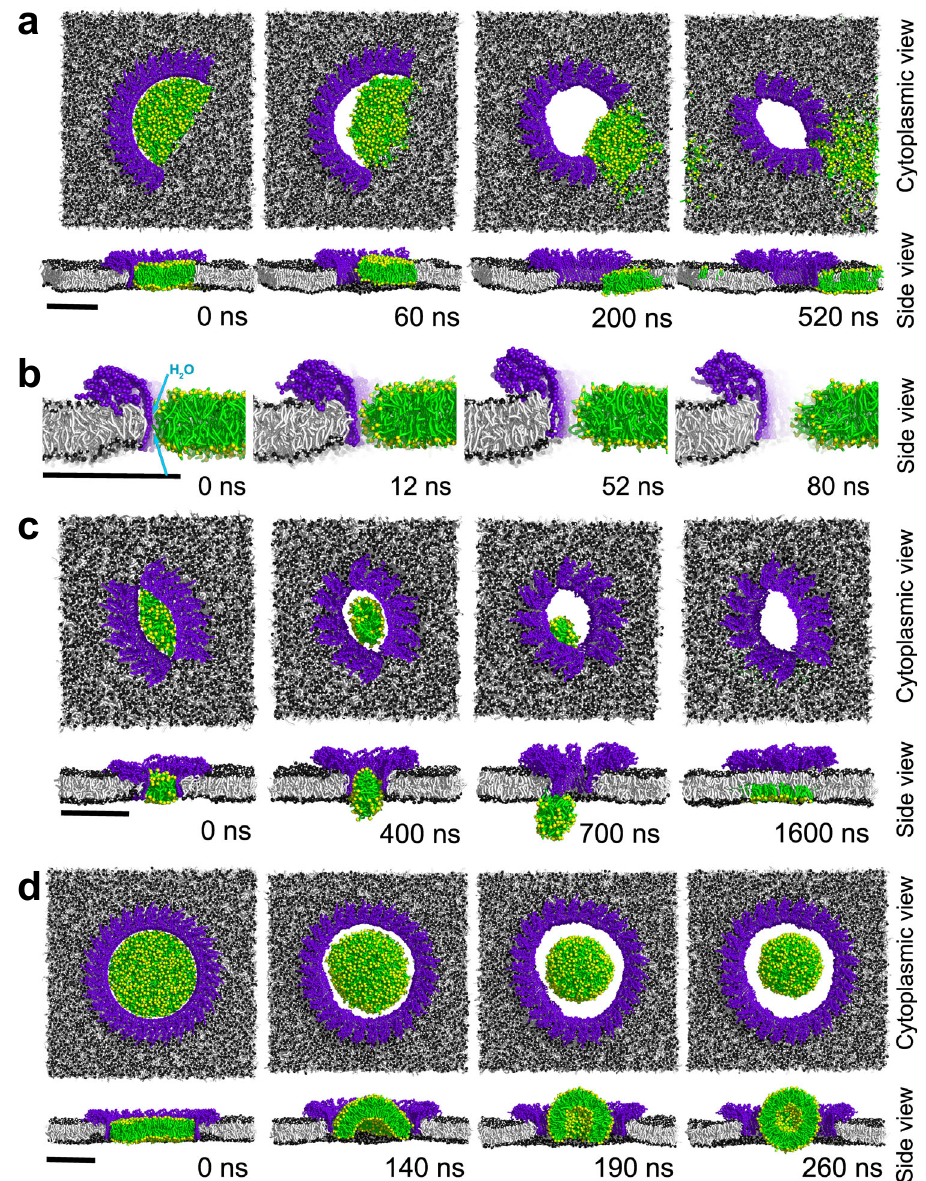
Fig. 7 Pore formation of membrane-inserted mGSDMA3 Nterm oligomers. a Pore formation of an arc-shaped oligomer assembled from 16 mGSDMA3 Nterm ( n = 8/8 simulations). b Lipid withdrawal from mGSDMA3 Nterm forming the arc-shaped oligomer shown in ( a ) at higher time resolution and structural detail. The hydrophilic (polar) surface of the transmembrane β -sheet formed by adjacent mGSDMA3 Nterm causes water to penetrate into the membrane. The intrusion of water along the β -sheet is followed by the reassembly of lipid headgroups (yellow), whose withdrawal from the hydrophilic surface opens the transmembrane pore. c Pore formation of a slit-shaped oligomer assembled from 14 mGSDMA3 Nterm . The lipids of the pre-pore fuse into the surrounding membrane (observed in 1 of 5, n = 1/5 simulations). d Pore formation of a ring-shaped oligomer assembled from 30 mGSDMA3 Nterm . Lipids left ring-shaped oligomers assembled from 27 ( n = 7/7 simulations) or 30 ( n = 6/6 simulations) mGSDMA3 Nterm as vesicles. mGSDMA3 Nterm are colored in purple, lipid fatty acid chains light gray, and lipid headgroups dark gray. Lipids withdrawing from the transmembrane β -sheet thereby forming the transmembrane pore are colored green with yellow headgroups. The top row in each sub fi gure shows the cytoplasmic view, the bottom row the side view. Simulation times are indicated for each snapshot. Scale bars, 10 nm. The entire simulations are shown in Supplementary Movie 2 – 10. Additional coarse- grained MD simulations of arc-, slit- and ring-shaped oligomers forming transmembrane pores are shown in Supplementary Fig. withdraw until they bulged and formed vesicles or nanodiscs that mGSDMA3 Nterm oligomers, whose pre-pores were plugged with exited into the solution and opened the lytic transmembrane pore lipid membrane allowed the pore formation process to be mon- (Fig. 7, Supplementary Fig. 15 and Movie 2 – 10). Occasionally, the itored (Fig. 7, Supplementary Fig. 15 and Movie 2 – 10). Because lipids inside oligomeric pre-pores bulged and fused with the the transmembrane β -hairpins lining the pre-pore are hydro- surrounding membrane. Preferentially, the lipids left the pre-pore phobic on the outside and hydrophilic on the inside (Supple- of small sized oligomers via membrane fusion (35,7%; n = 5/14) mentary Fig. 16) 21 , the simulations showed the hydrophilic inner surface of the β -stranded pre-pore to draw water into the protein- or nanodiscs (50%; n = 7/14) and less often as vesicles (14.3%; lipid interface (Fig. 7a, b). This process forced the lipids to n = 2/14), while they left large ring-shaped oligomers always as